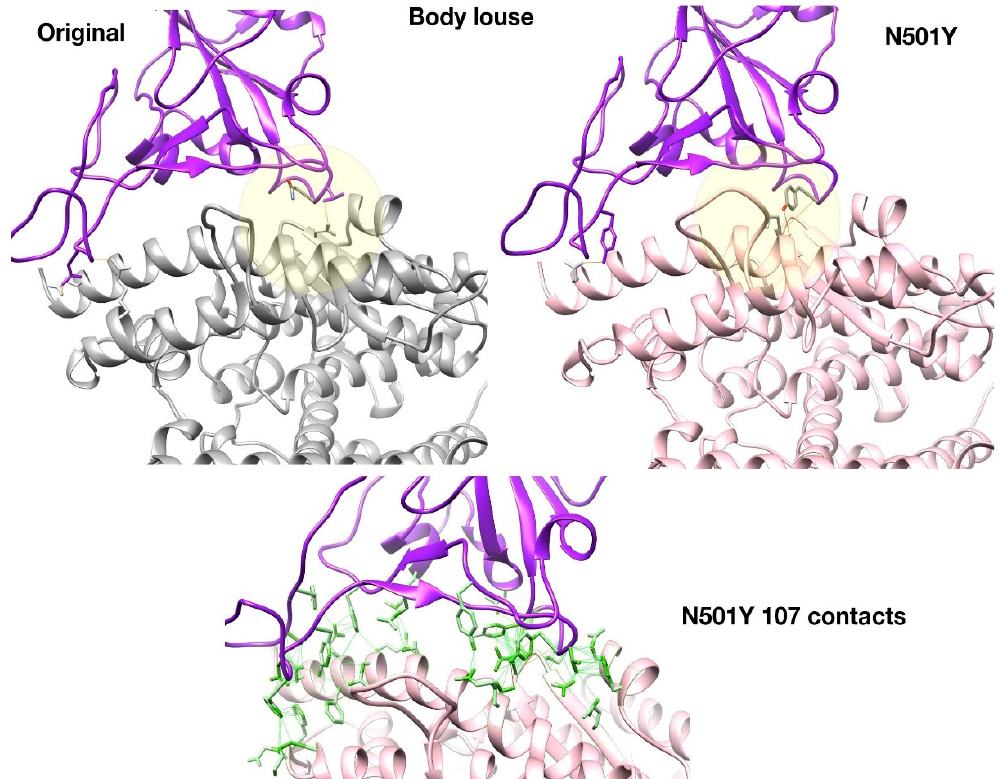
Figure 4. Structures of N501Y mutant show increased H-bond stabilisation in body